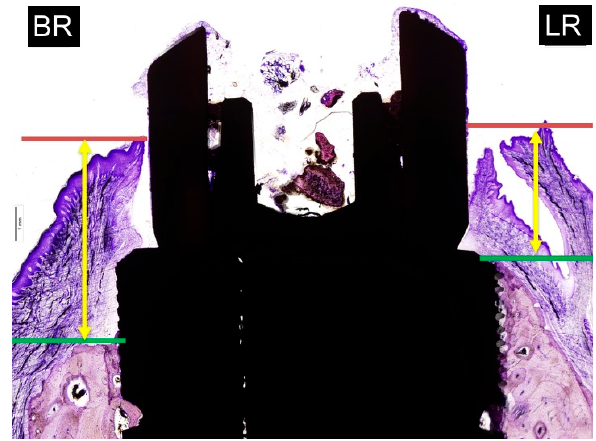
Figure 6. Measurements of soft tissue thickness: BR: buccal crest resorption (distance from the top of the implant shoulder to the first BIC in the buccal crestal side. LR: lingual crest resorption (distance from the top of the implant shoulder to the first BIC in the lingual crestal side).